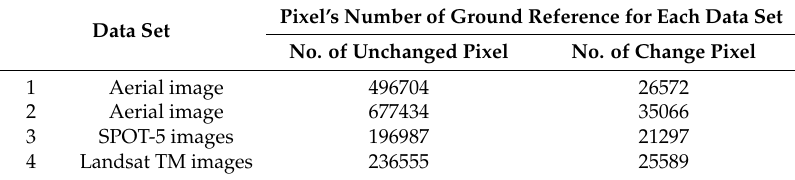
Table 3. Details of ground reference for each data